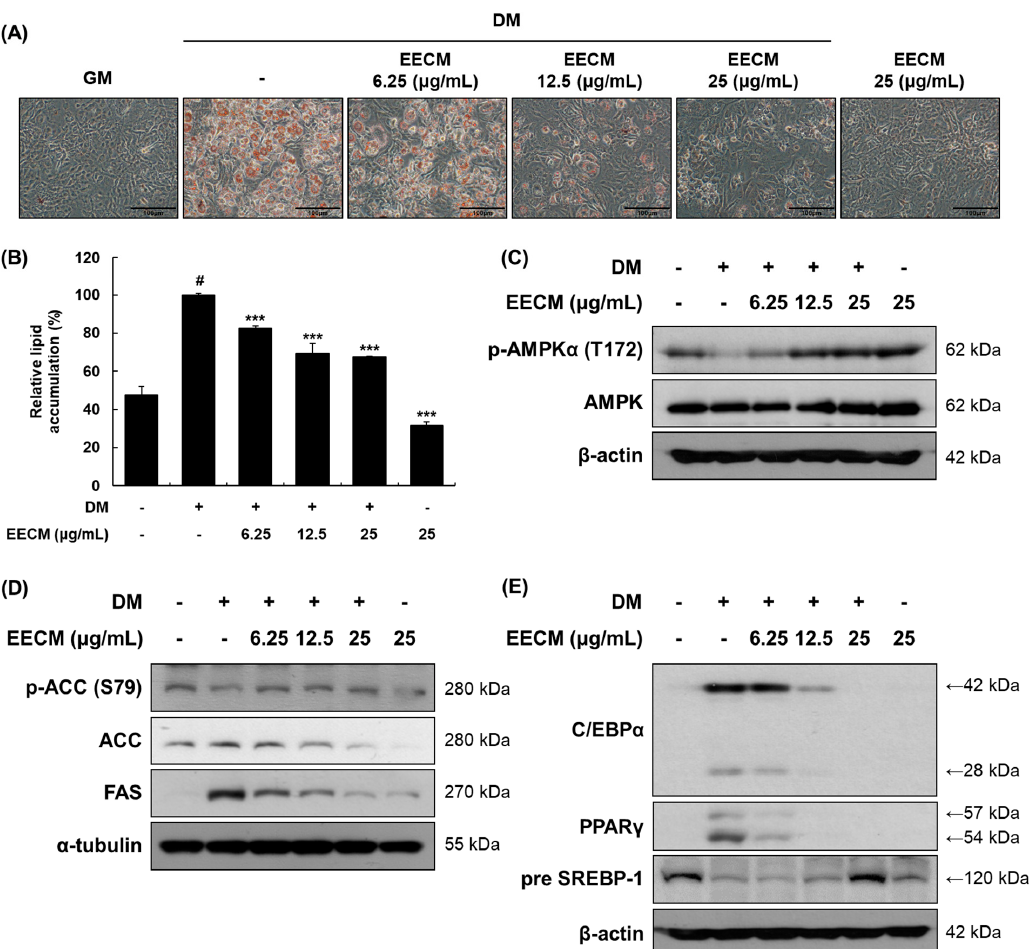
Figure 2. Inhibitory effects of EECM on intracellular lipid accumulation, adipogenesis, and lipogene- sis in 3T3-L1 cells. The 3T3-L1 cells were cultured in the growth medium (GM) for four days. After the cells reached confluency, they were cultured with or without methylisobutylxanthine, dexametha- sone, and insulin (MDI) and various concentrations of EECM. ( A ) Relative microscopic images of Oil-Red-O-stained 3T3-L1 cells. ( B ) Quantitative lipid accumulation ratio. After differentiation, total protein was extracted and detected by via Western blotting analysis. Expression levels of ( C ) AMPK α pathway proteins and ( D ) lipogenic and ( E ) adipogenic transcription factors. Values are represented as the mean ± standard deviation (SD). # p < 0.05 vs. the GM group; *** p < 0.001 vs. the differentiation medium (DM)